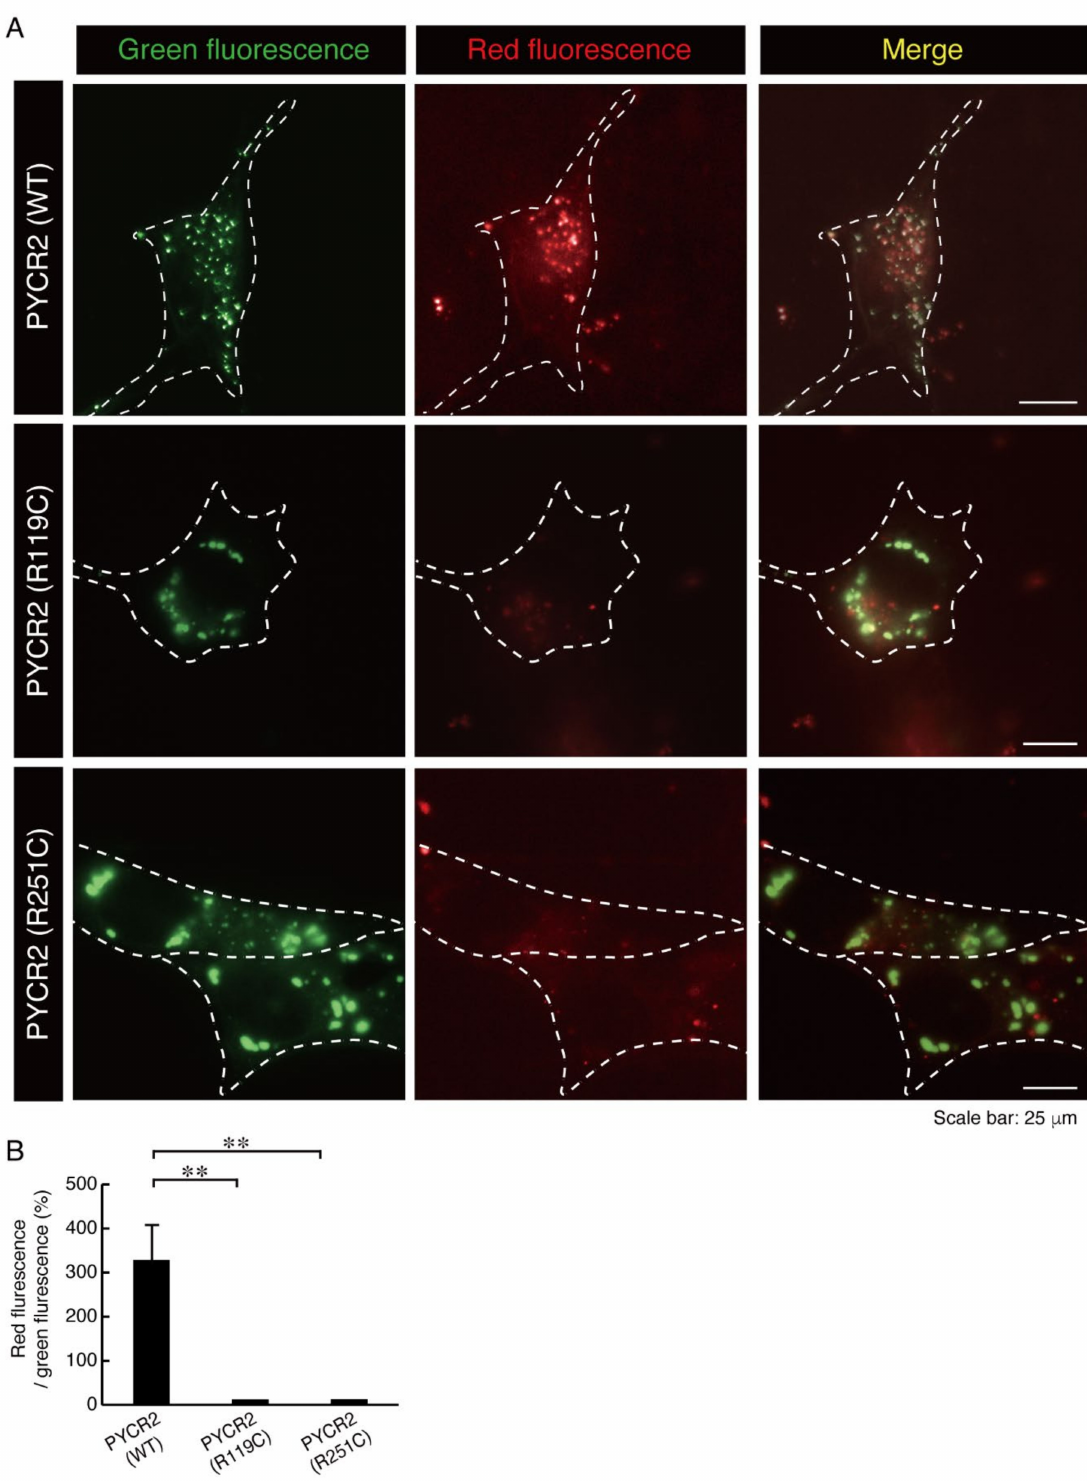
Figure 7. The mutated PYCR2 proteins decrease mitochondrial membrane potentials. ( A , B ) FBD-102b cells expressing wild type (WT), R119C, or R251C of PYCR2 (green) were treated with JC-1 dye (red). The approximate outline of the cell is surrounded by dotted white lines. JC-1 was taken up by wild type PYCR2-expressing mitochondria that maintained normal membrane potential. Pixel ratios of red fluorescence per green fluorescence were depicted to be statistically significant (**, p < 0.01; n = 10